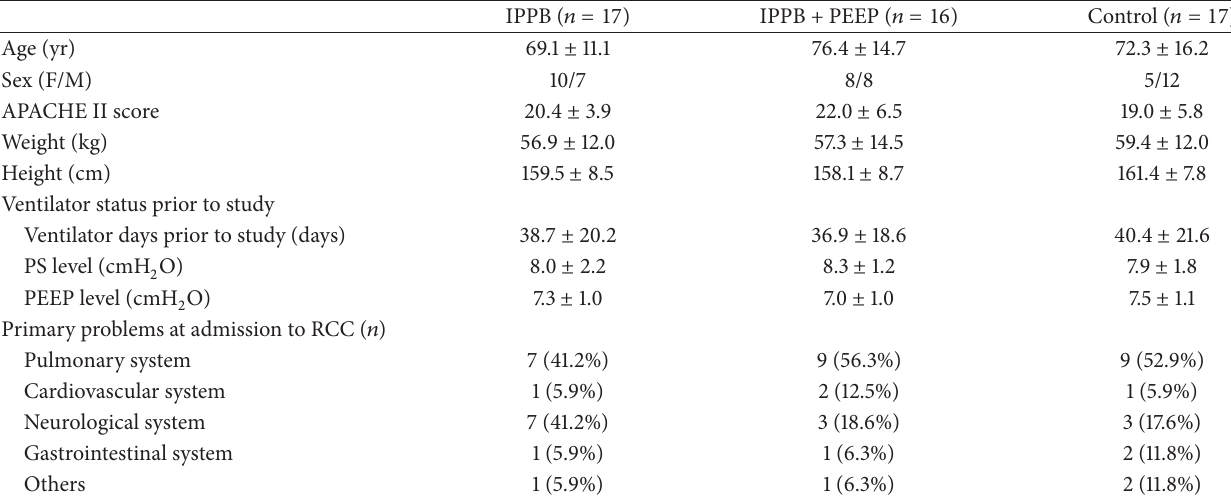
Table 1: Baseline characteristics of study participants.